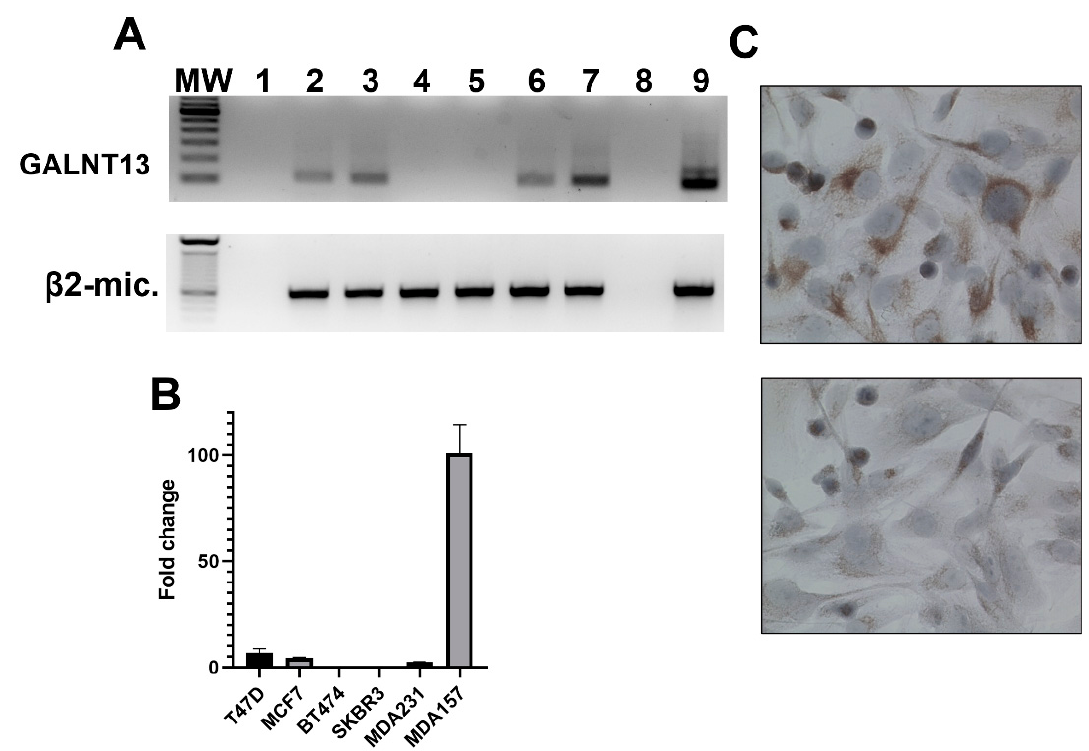
Figure 2. GalNAc-T13 expression in human breast cancer cell lines. ( A ) Nested reverse-transcription PCR amplifying a 105 bp fragment of GALNT13 mRNA and one-round reverse-transcription PCR amplifying a 596 bp fragment of β 2-microglobulin as cDNA quality control: MW, 100 bp DNA ladder (Thermo Fischer); 1, master-mix negative control; 2, T47D; 3, MCF7; 4, BT474; 5, SKBR3; 6, MDA-MB-231; 7, MDA-MB-157; 8, ultrapure water as negative control; 9, Hela cell line as positive control. ( B ) Quantitative real-time PCR for the same breast cancer cell lines. ( C ) Immunocytochemistry evaluating GalNAc-T13 expression at the protein level in MDA-MB-157 cell line in the upper image and negative control in the lower image (magnification: 400X).